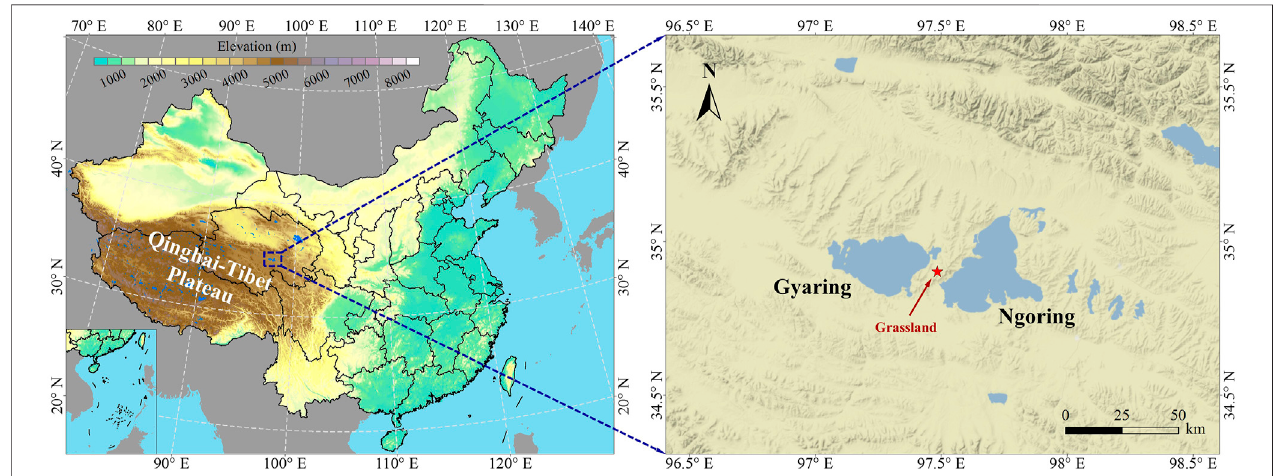
FIGURE 1 | Terrain height of Gyaring and Ngoring lakes and the location of fi eld observation site.